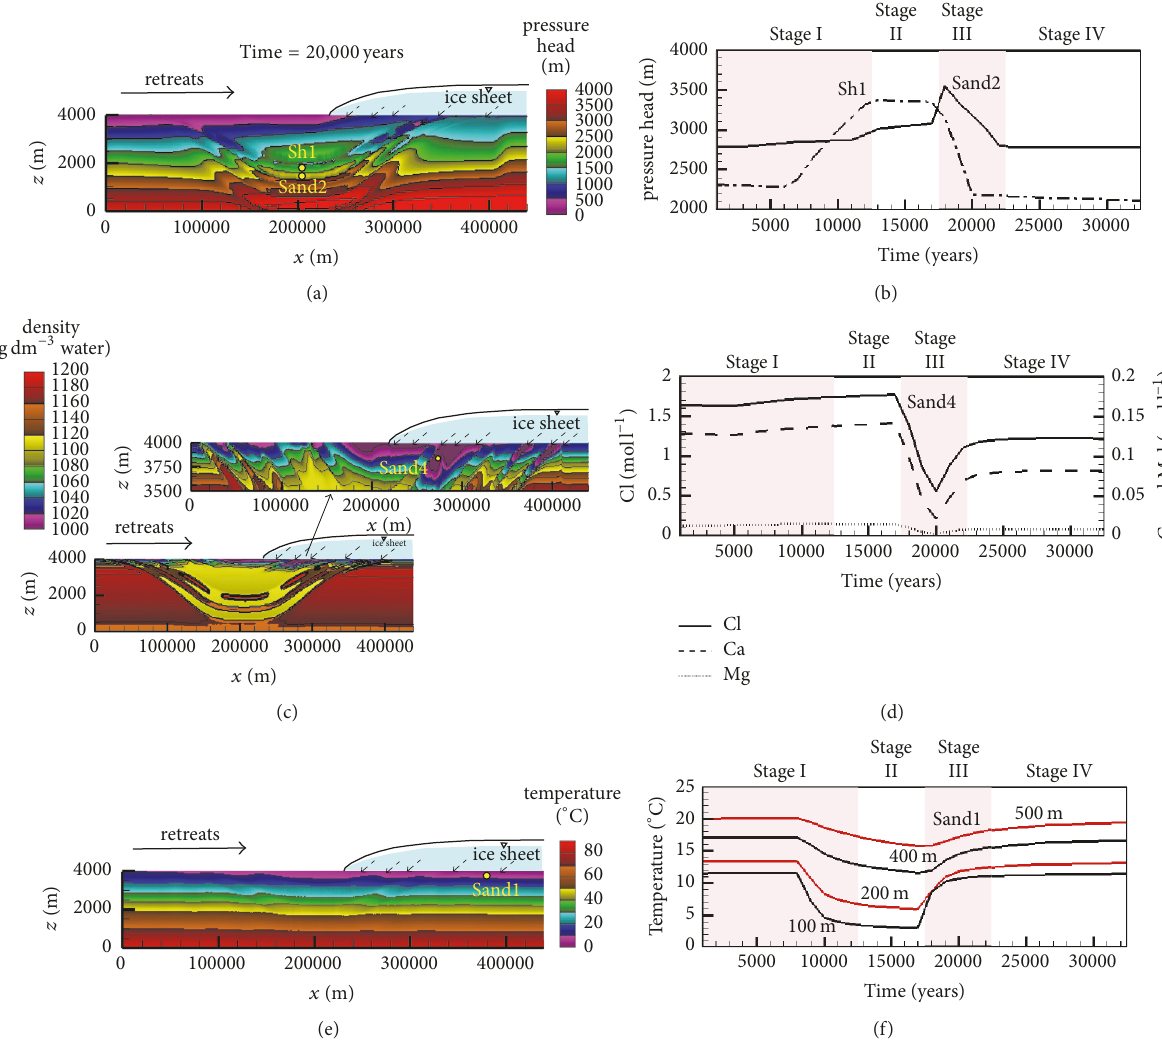
Figure 4: Simulation results for the illustrative sedimentary basin simulation. (a) and (b) Spatial distribution of point pressure heads at 20,000 years, and its temporal evolution at observation points located in a sandstone aquifer (Sand2, observation point located at 2,800 m depth) and in a shale aquitard (Sh1, observation point located at 2,300 m depth). (c) and (d) Spatial distribution of density at 20,000 years, and its temporal evolution at observation point located in sandstone aquifer (Sand4 observation point located at 300 m depth). (e) and (f) Spatial distribution of temperature at 20,000 years, and its temporal evolution at observation points located in sandstone aquifer (Sand1, depths indicated on